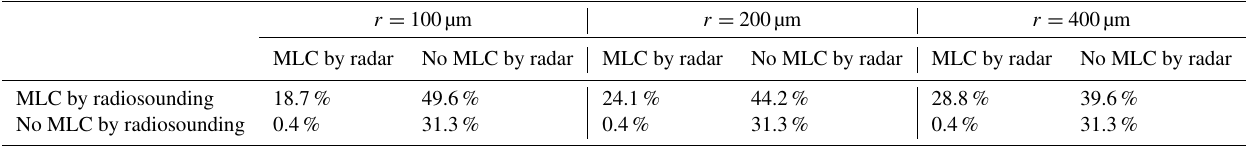
Table 3. Evaluation of the MLC results of radiosonde detection (classification step 1) in comparison to radar detection (classification step 2). “MLC by radar” is given by cloud category 8 for the non-seeding cases and by cloud category 5 for the seeding cases. The evaluation is done for the ice crystal sizes r = 100, 200 and 400µm. The values are rounded to one decimal place. r = 100µm r = 200µm